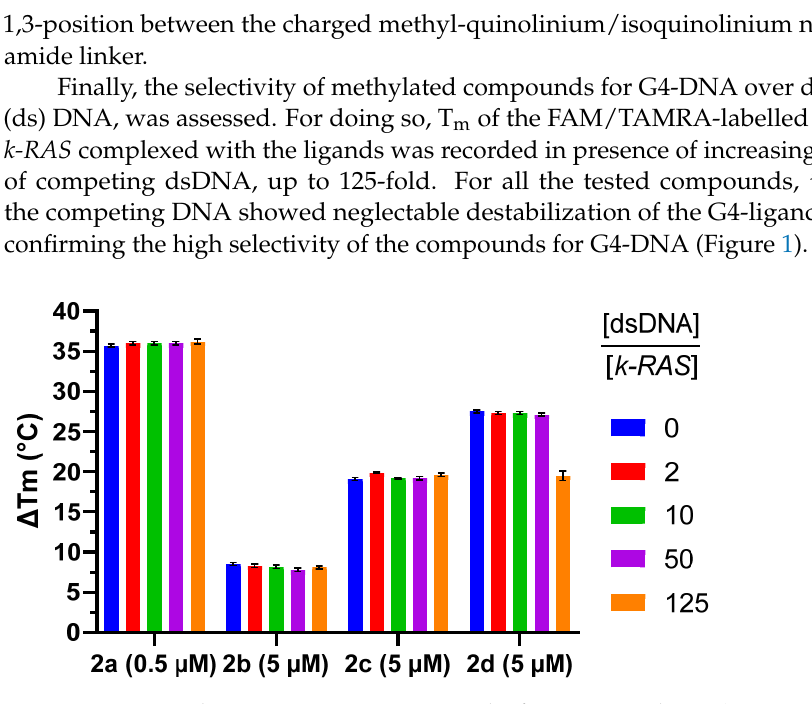
Figure 1. FRET-melting competition assay results for compounds 2a – d at 0.5 µ M ( 2a ) and 5 µ M ( 2b – d ) complexed with k-RAS G4 (0.2 µ M), challenged with increasing concentrations of non-labeled 26ds DNA (dsDNA) (0.4 to 25 µ M) competitor. Experiments performed in potassium cacodylate buffer (60 mM K + , pH 7.4).